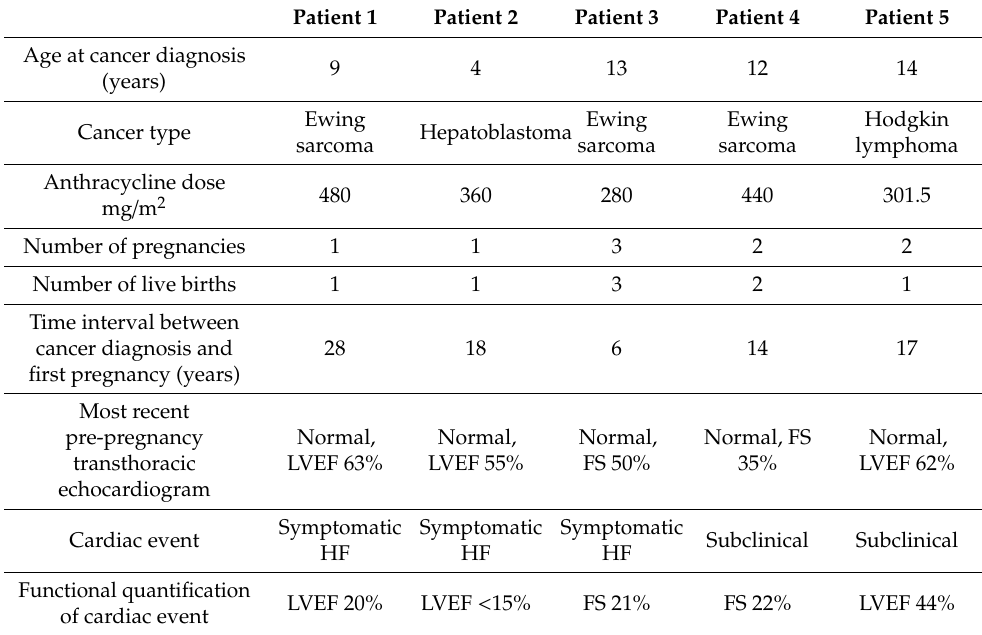
Table 2. Clinical characteristics of patients with documented peripartum cardiac events ( n =